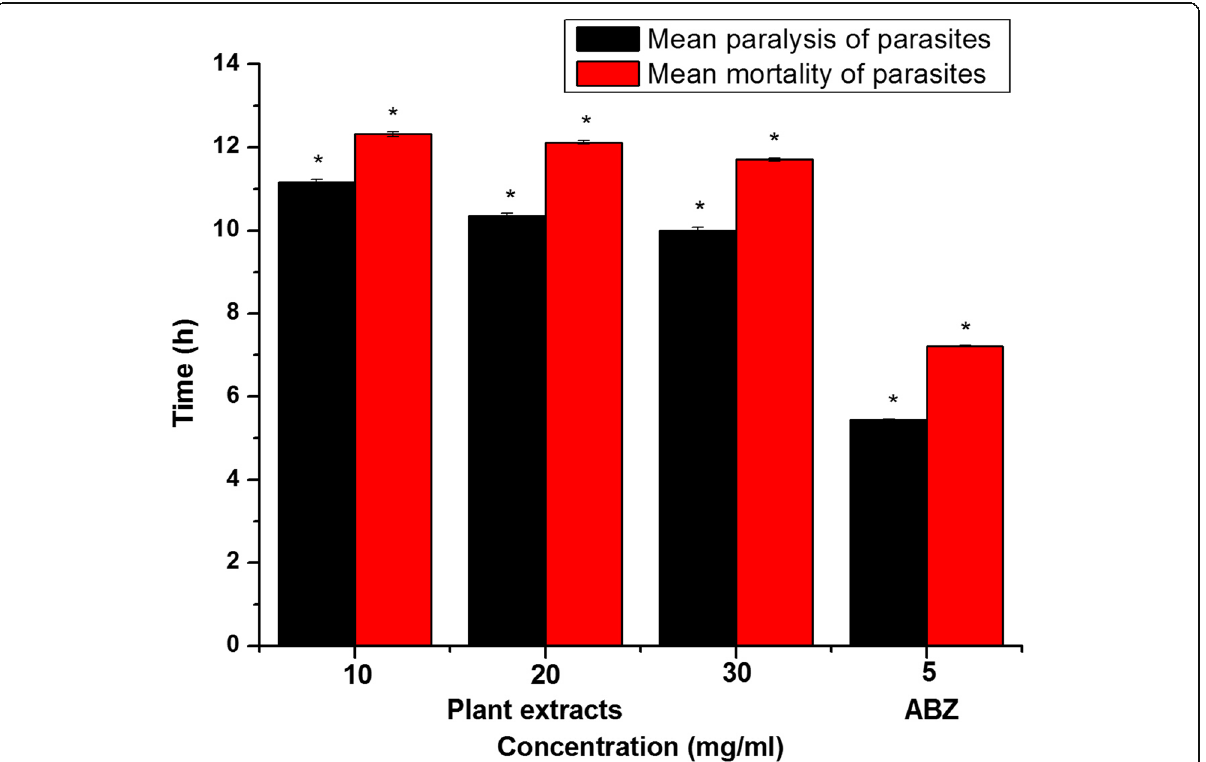
Fig. 3 In vitro anthelmintic effects of A. racemosus methanolic root extract against S. obvelata . Data is expressed as mean ± SEM. * p ˂ 0.0001 compared with control group, student ’ s t -test